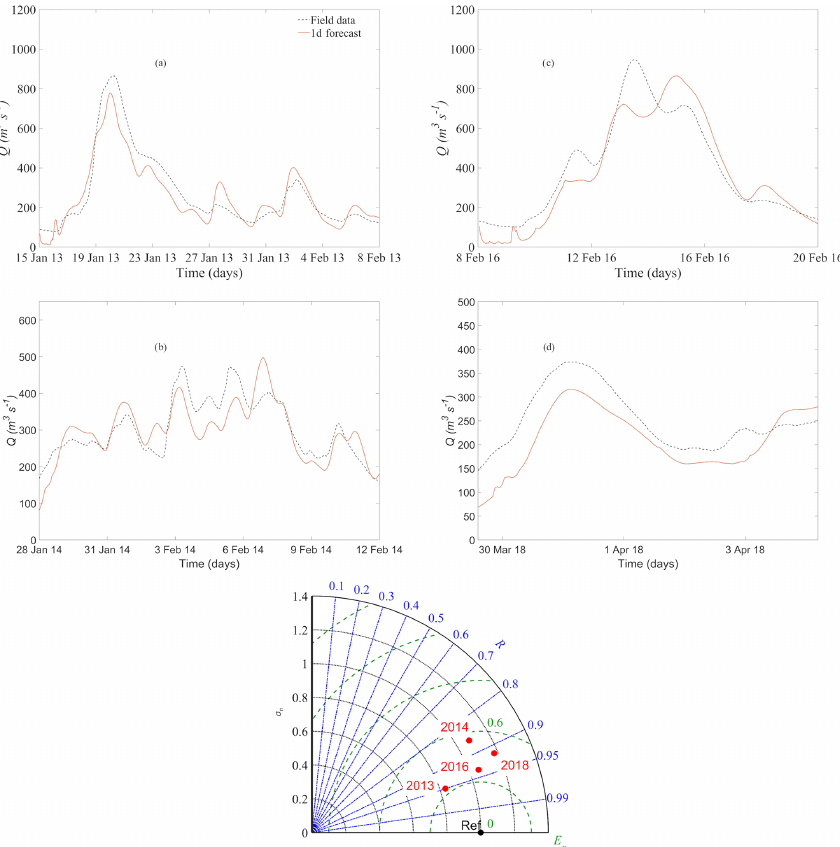
Figure 3. Time series of the registered streamflow (dashed line) and numerical streamflow (orange line) of the validation events: (a) Jan- uary 2013, (b) January 2014, (c) February 2016 and (d) March 2018. Taylor diagram of the validation cases is also shown.